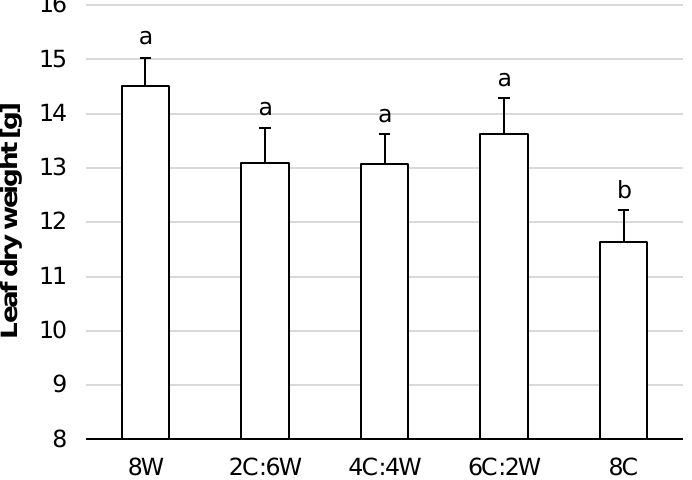
Figure 9. Effect of growing media ratio on WFL [g], 35 DAT. Vertical bars denote standard error.